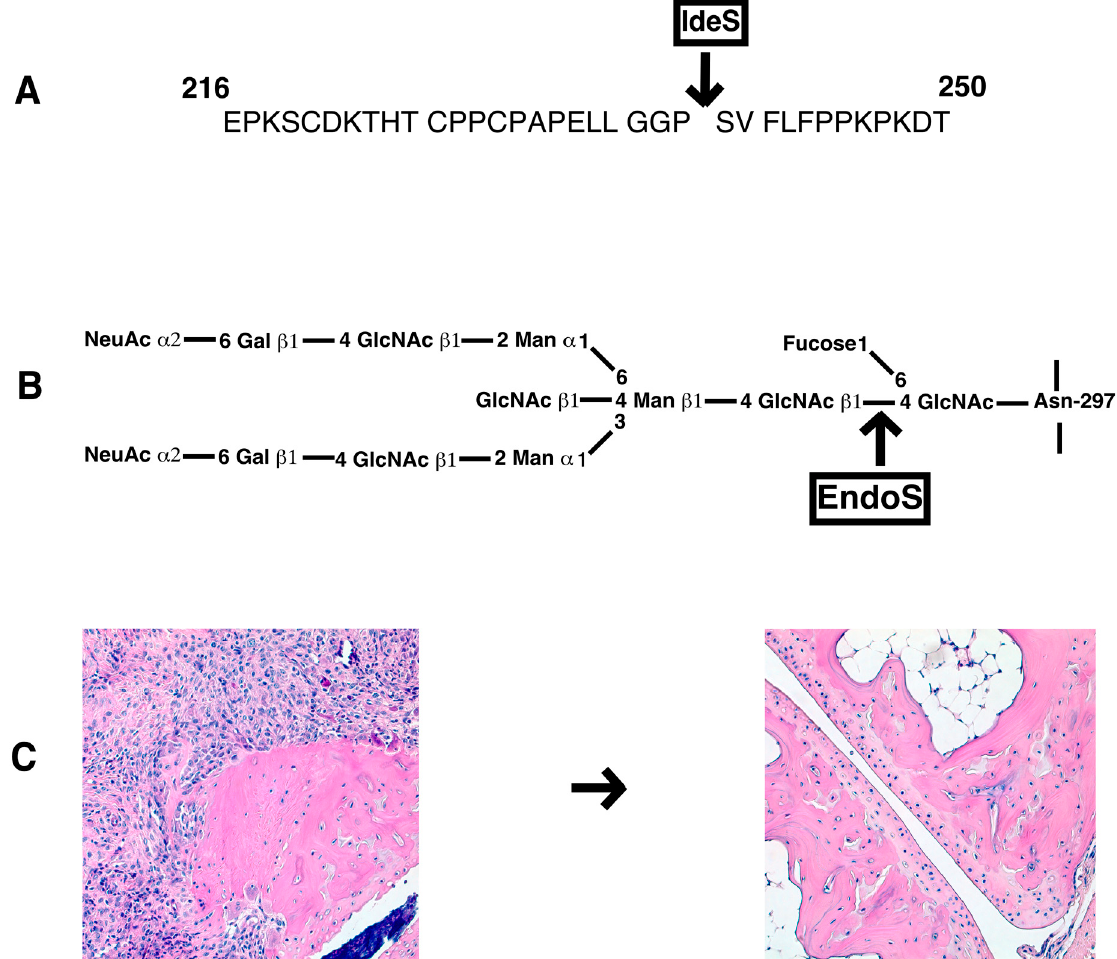
Figure 3. Bacterial enzymes as therapeutics for IgG dependent diseases. Streptococcus pyogenes secreted IdeS ( A ) cleaves IgG molecules at the hinge region and EndoS ( B ) cleaves N-linked carbohydrates specifically present on Fc region. Arthritis is ameliorated either after IgG-degrading enzyme (IdeS) or Endo- β - N -acetylglucosaminidase (EndoS) cleavage of pathogenic IgG ( C ). HE stained joint morphology of mouse with and without arthritis after treatment. Magnification, 10×.